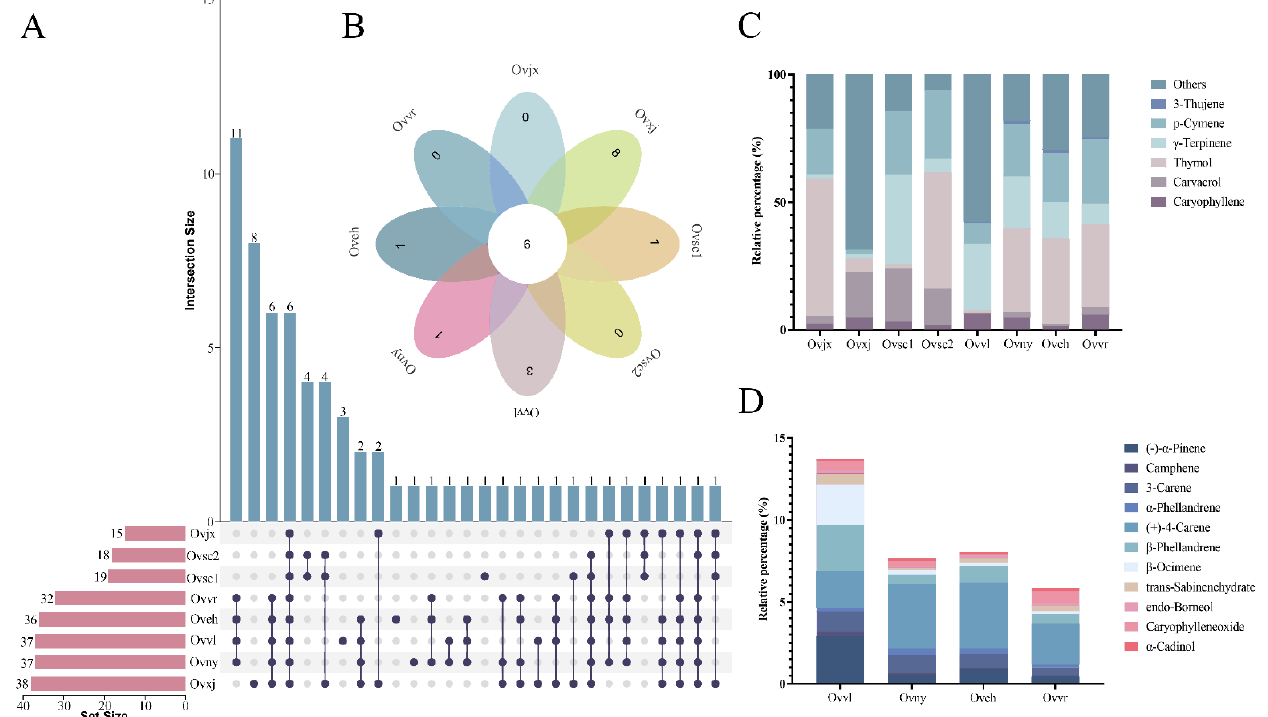
Figure 3. Distribution of common and unique compounds. Amounts of OEO chemical compounds illustrated by an UpSet Venn diagram ( A ) and flower diagram ( B ). Stacked graph ( C ) of common compounds in all samples. Stacked graph ( D ) of shared compounds in all cultivated varieties.